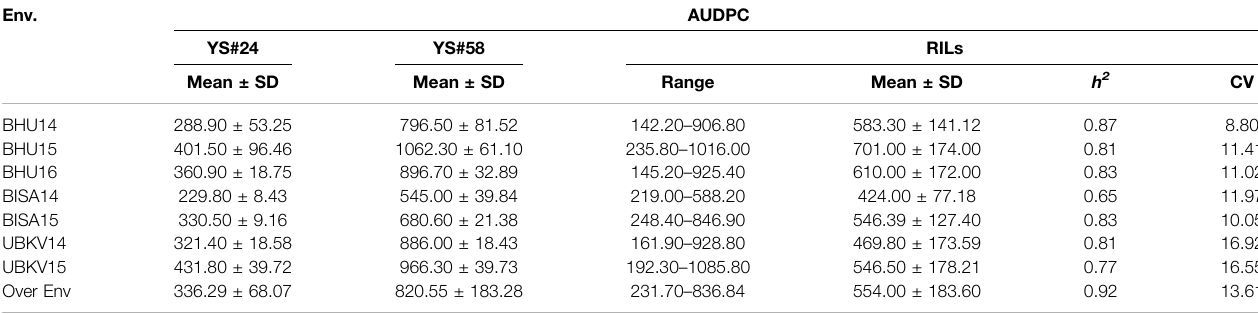
TABLE 1 | Disease response to SB of parents and RILs measured in different environments.